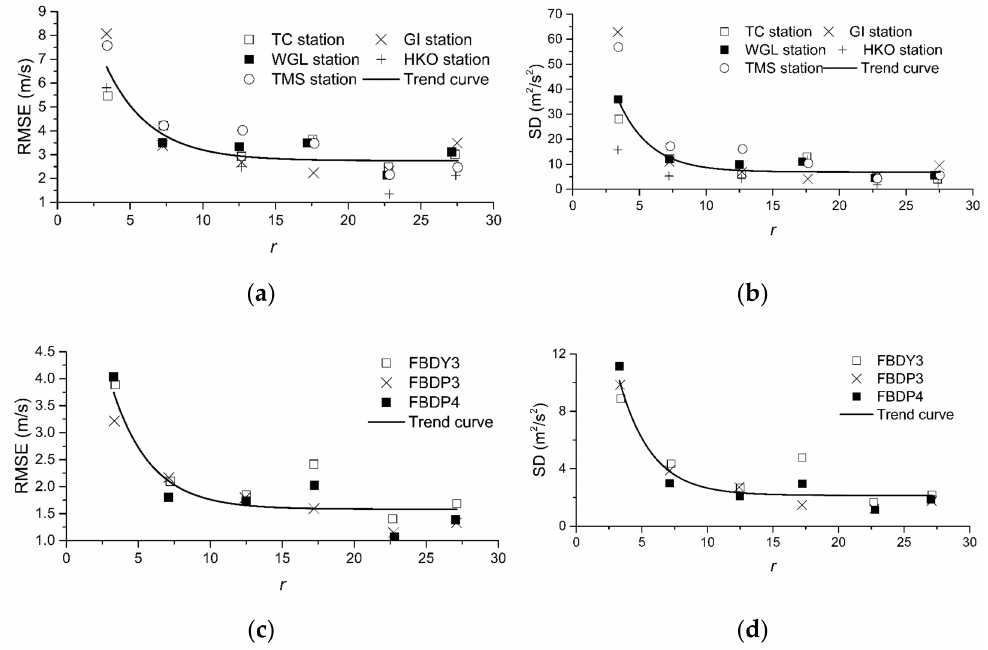
Figure 8. Wind speed error variation as a function of the r. ( a , b ) RMSE and SD of wind speed over land; ( c , d ) RMSE and SD of wind speed over the